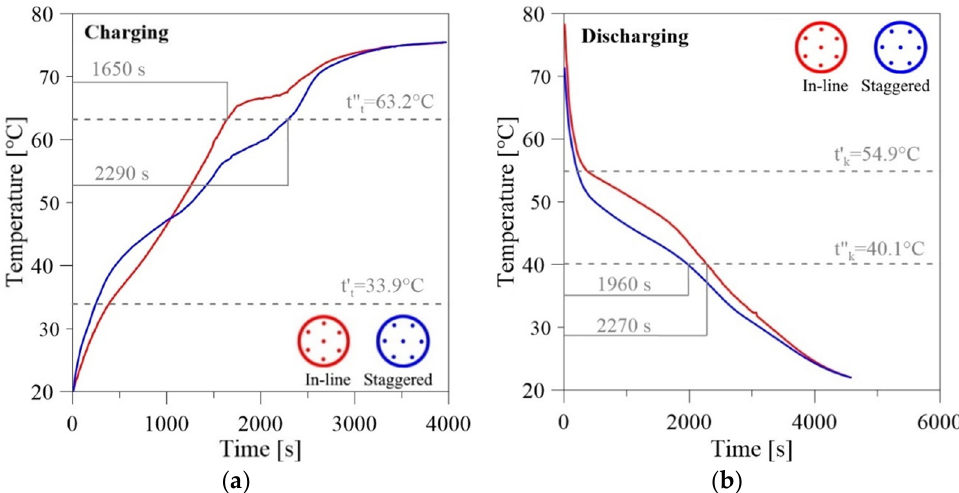
Figure 7. Effect of the tube arrangement for LTP56: ( a ) charging; ( b ) discharging.